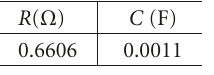
Table A.2: Parameters of a local capacitive load of test system 1.